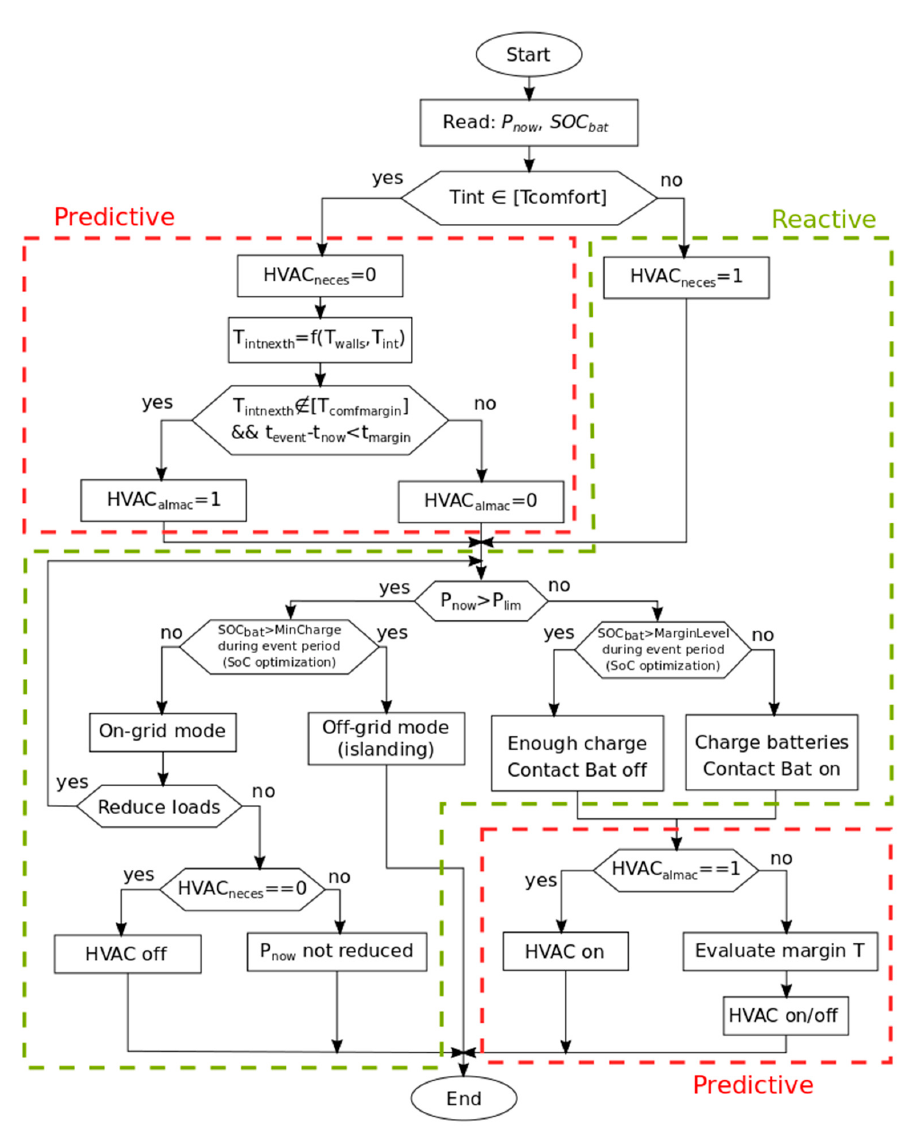
Figure 11. Flow diagram for homeostatic control.